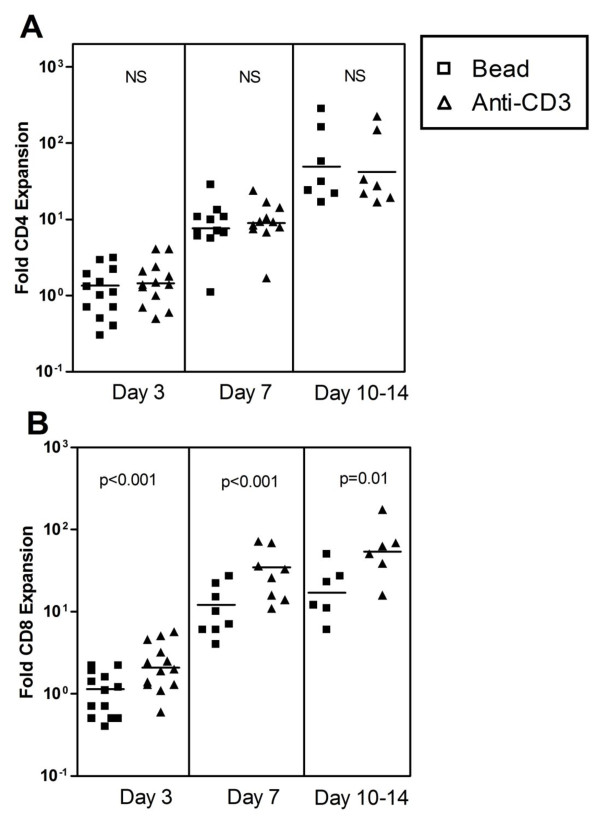
Comparison of CD4 (A) and CD8 (B) growth when bead-treated T cells were restimulation with anti-CD3/CD28 beads (squares) or anti-CD3/irradiated MMCs (triangles). T cell expansion was monitored using CFSE labeled cells and flow cytometry as described in the methods. CD4 expansion was similar in response to either stimulus. By contrast, bead-treated CD8 cells expanded significantly less well than anti-CD3-treated cells at all time points. The p values with obtain using the Wilcoxon matched pairs test are indicated at the top of each box.